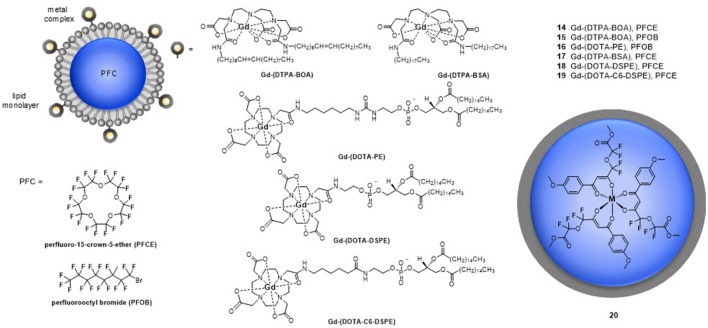
Schematic representations of paramagnetic perfluorocarbon nanoparticles. Gd-complexes are embedded into lipid monolayers that encapsulate perfluorocarbon cores (14, Neubauer et al., 2008; 15–16, Hu et al., 2011; 17–19, de Vries et al., 2014) or perfluorocarbon substituted parmagnetic metal complexes form nano-emulsions (20, Kislukhin et al., 2016).